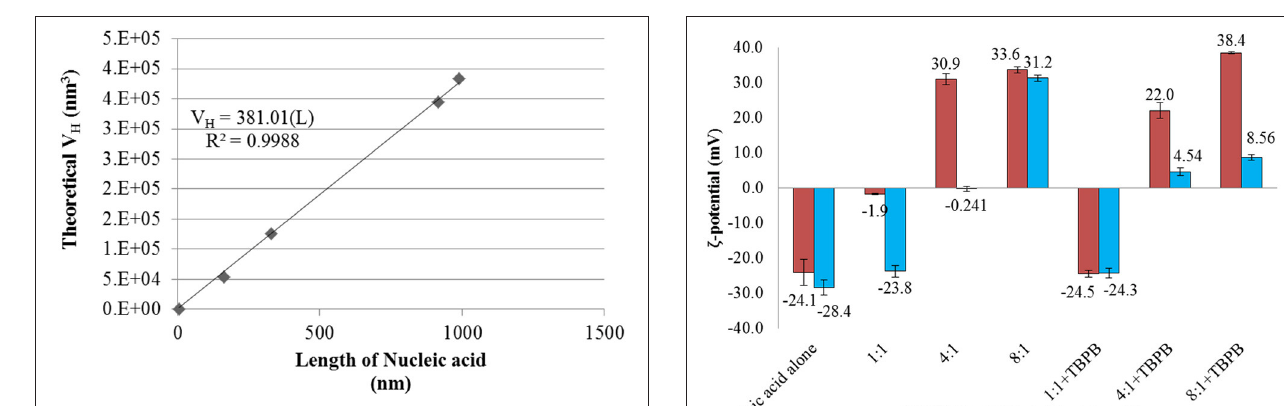
and Tat 2 :scsiRNA:TBPB, showing significances of p < 0.05.